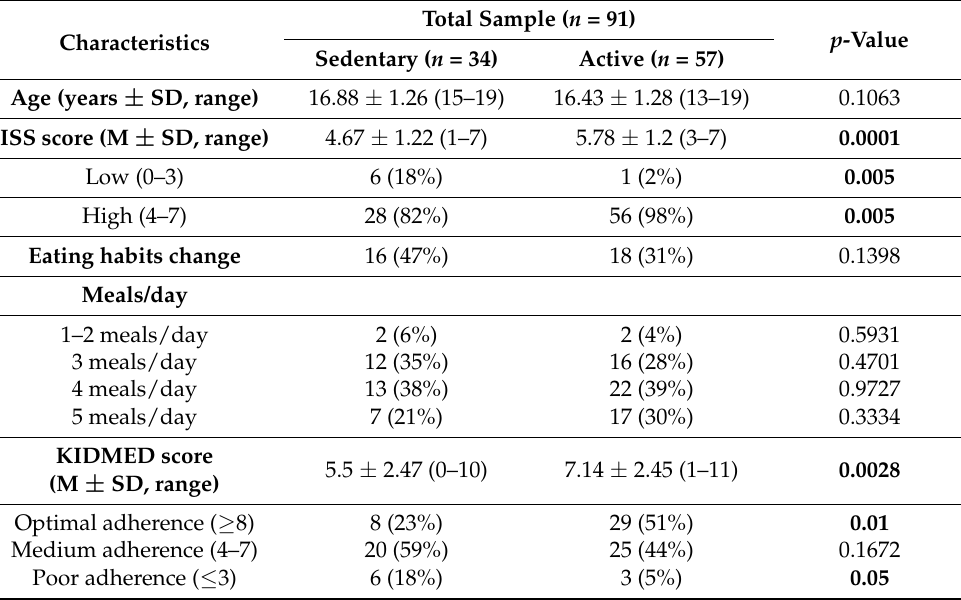
Table 3. Dietary and physical activity habits in sedentary and active adolescents during the lockdown.